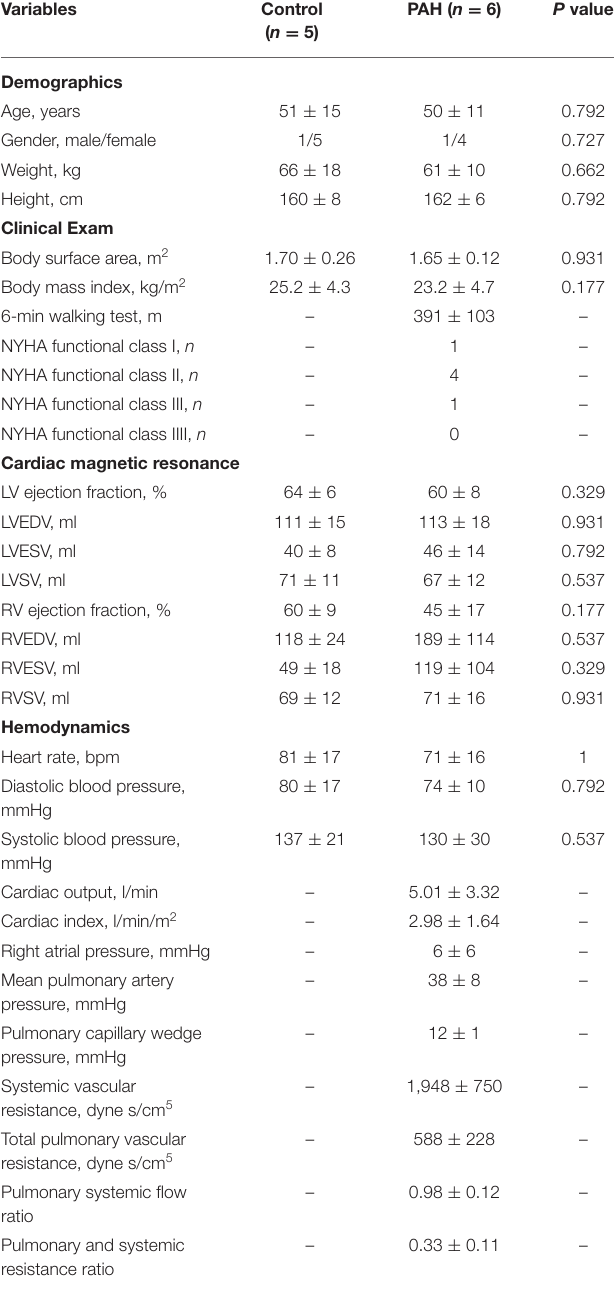
TABLE 1 | Demographics and clinical examinations in PAH and normal control